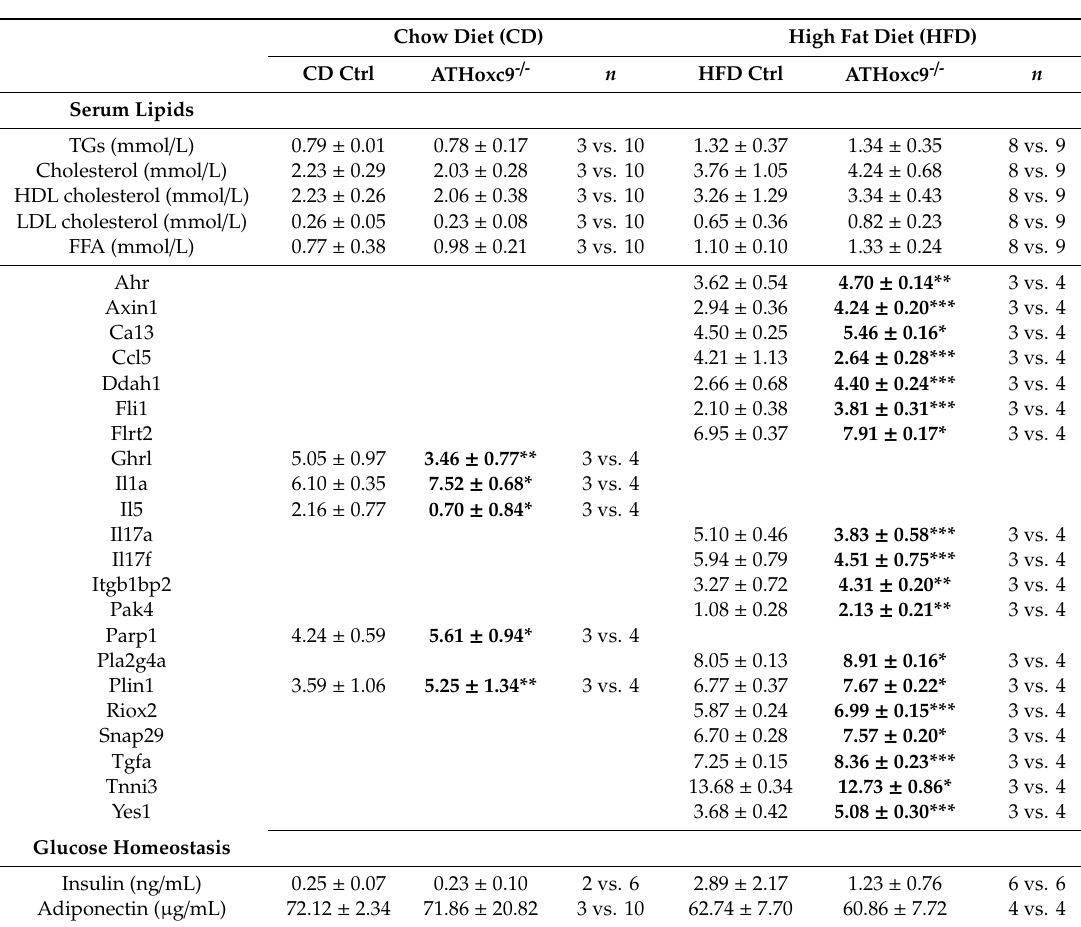
Table 1. Serum concentrations of the parameters of lipid metabolism and glucose homeostasis. Measured in male mice at an age of 30 (CD) or 26 weeks